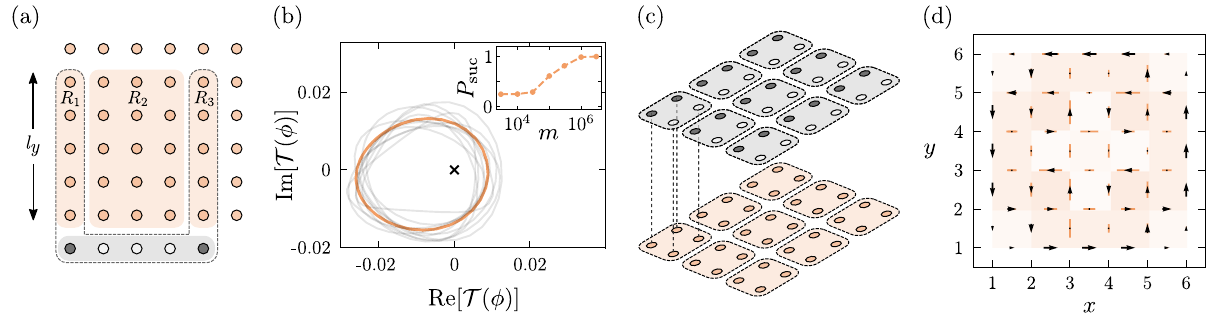
FIG. 8. Measurement of many-body Chern number (MBCN) and bond currents in the Hofstadter-Bose-Hubbard (HBH) model. (a) Quench scheme for measurement of MBCN. This quantity is estimated by a quench on a small patch: coupling rectangular regions R 1 and R 3 (orange vertical strips of length l ) with five additional sites containing two bosons (gray horizontal strip), followed by y projective measurement on R 2 (large orange block). (b) We illustrate the parametric plot of the quantity h T ð ϕ Þi as a function of ϕ ∈ ½ 0 ; 2 π Þ for the ground state of a HBH model, with three particles on 36 sites, and a flux of 2 πα ¼ π = 2 per plaquette in open boundary conditions. The true curve of T ð ϕ Þ is plotted in orange, which we see winds around the origin once, corresponding to a ˆ T MBCN of C ¼ 1 . We plot in gray several representative curves of ð ϕ Þ estimated with m ¼ 3 × 10 6 random samples. Such curves ˆ C are all 1. Inset: the probability deviate from the ideal T ð ϕ Þ , but nevertheless all have winding number 1; hence their estimated MBCN P of obtaining the correct MBCN is plotted as a function of number of samples. Beyond a critical number of measurements ∼ 3 × 10 5 , suc the MBCN can be reliably estimated. (c) Quench scheme to measure currents across every bond. We isolate plaquettes of four lattice sites and couple it to an additional plaquette of four sites and two bosons in a second layer. In order to determine the currents on every bond, we perform two sets of patched quenches on nonoverlapping plaquettes (not shown). (d) The ground state shows a pattern of persistent edge currents. The statistical uncertainty arising from 5000 sample measurements is indicated by the orange bars: for this state, 5000 measurements are sufficient to achieve a good signal-to-noise ratio. As a visual aid, we color each plaquette with the curl of the current in that